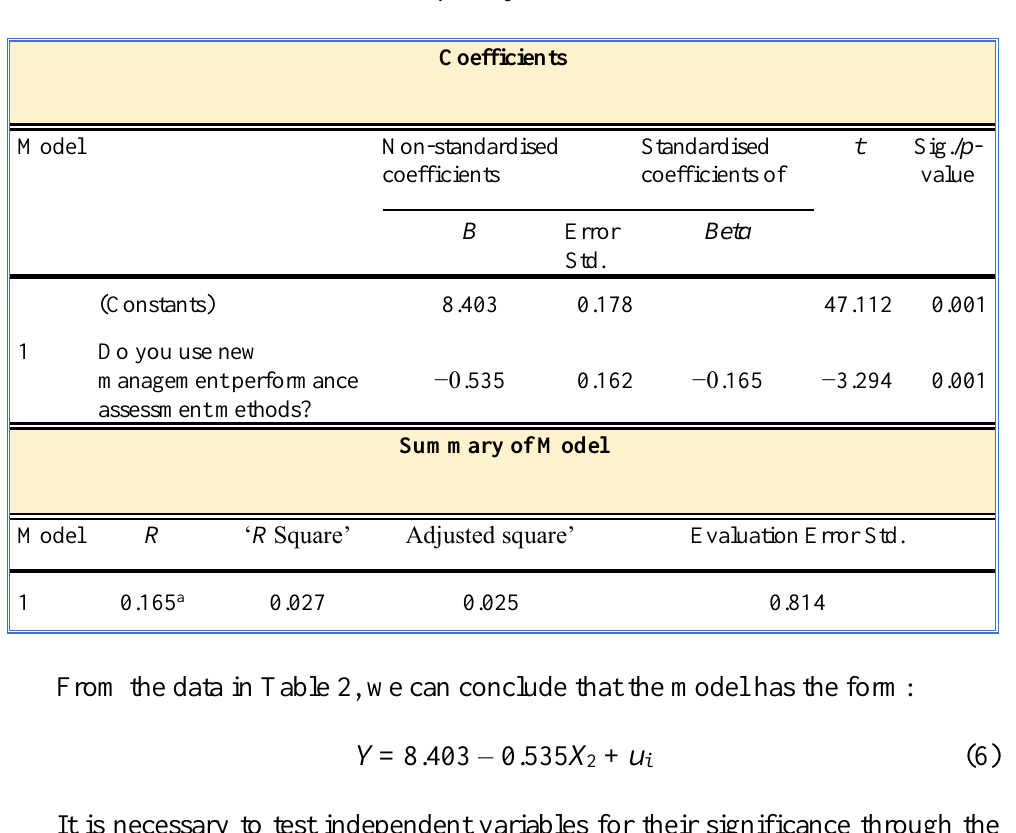
Table 2. Applying Methods for Managerial Staff Performance Assessment (developed by the